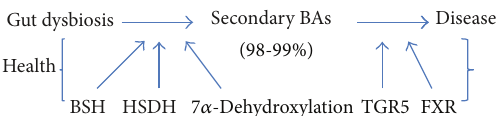
Figure 1: Proposed schema of interplay between gut dysbiosis, modified BA pool, and disease. In health, secondary BAs are modi- fied by microbial BSH and HSDH enzymes through deconjugation, oxidation, and epimerization as well as dehydroxylation via 7 𝛼 - dehydroxylation activity. The BA metabolites as a result of microbial transformations act as signaling molecules via the TGR5 and FXR receptors to regulate intestinal homeostasis. In disease, it is unclear how gut dysbiosis causes a modified BA pool, which then results in disease,whichispossiblysecondarytoimpairedBAsignaling.(BSH: bile salt hydrolases; HSDH: hydroxysteroid dehydrogenases; TGR5: G protein coupled BA receptor; FXR: farnesoid x